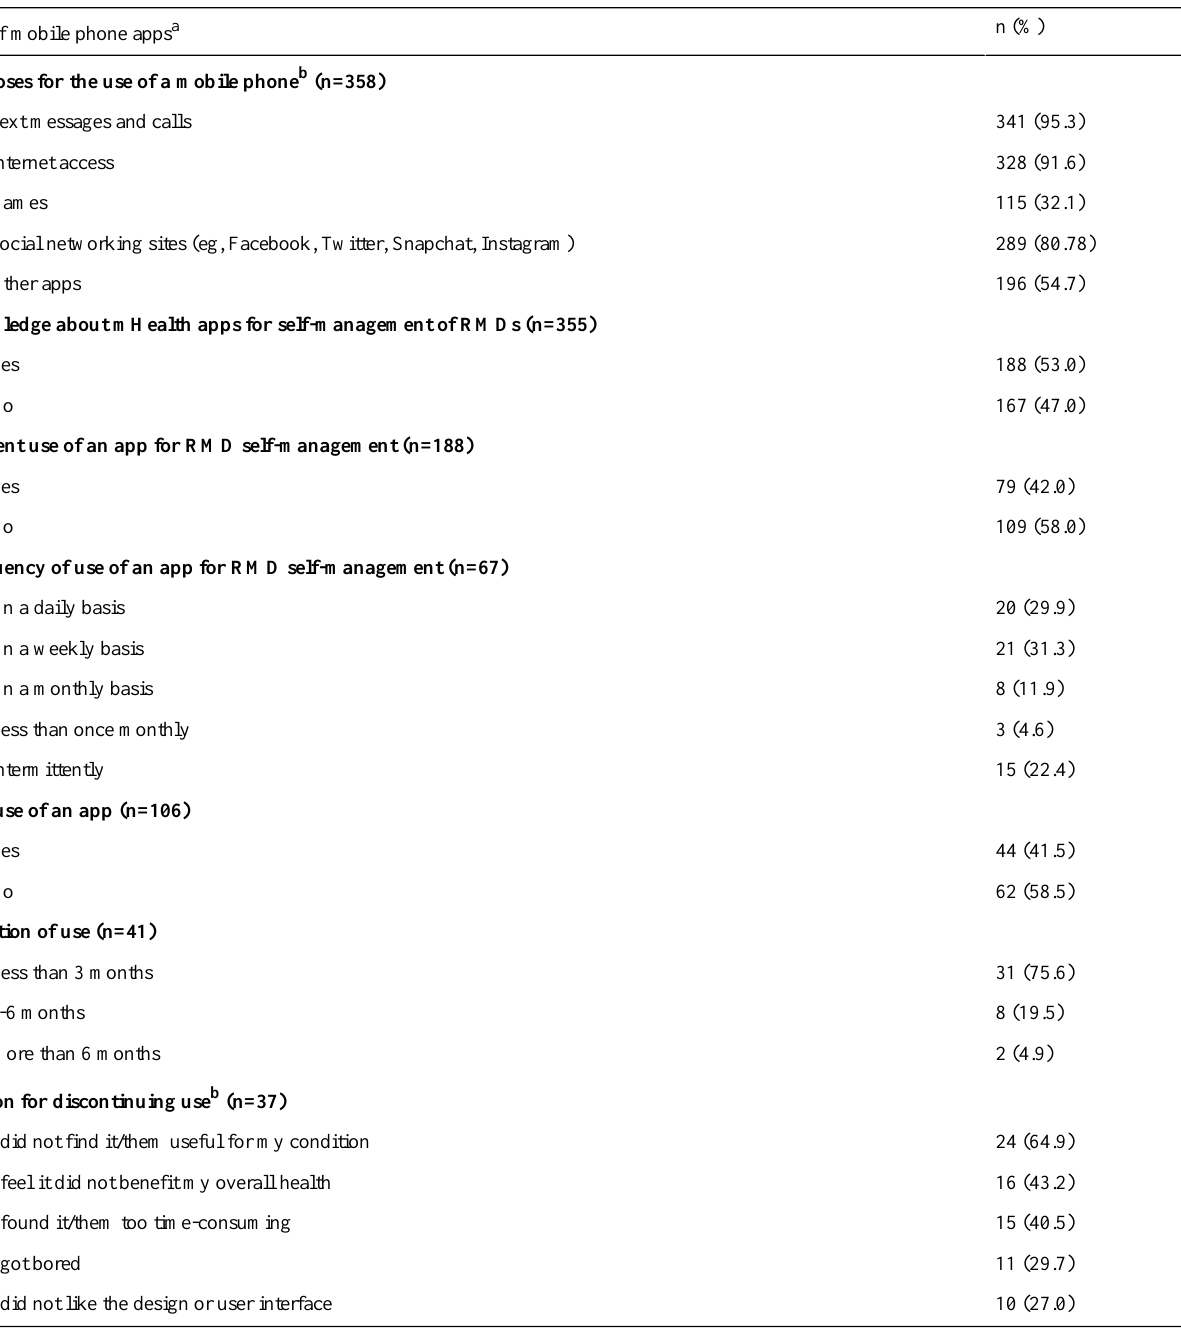
n (%)Use of mobile phone apps a